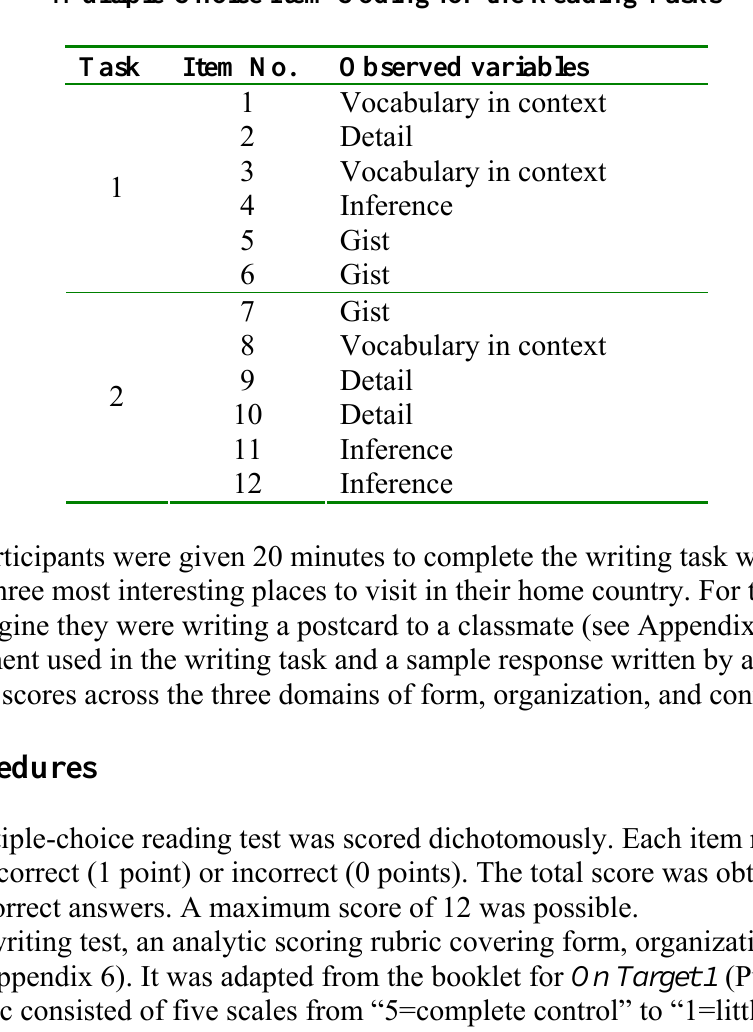
Multiple-Choice Item Coding for the Reading